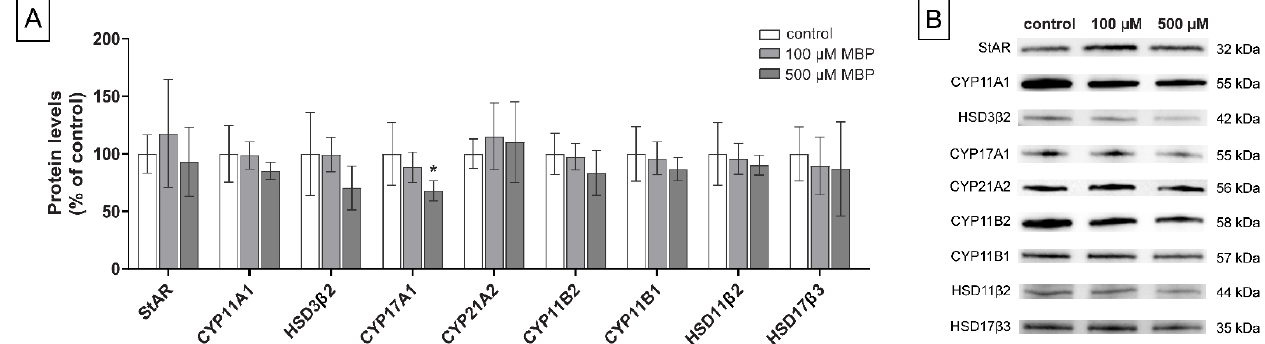
Figure 6. Levels of nine different steroidogenic proteins were measured by western blot ( A ) in H295R cells exposed to 0 (0.1% DMSO, solvent control), 100, or 500 µM MBP for 48 h, with stimulation of the steroidogenesis by 0.1 mM dbcAMP. Values represent mean ± S.D. from six replicates per treatment. Representative blots for each protein are shown ( B ). Total protein stain was used as a loading control. The statistically significant differences from control are indicated as follows: * p < 0.05 (One-way ANOVA followed by Dunnet’s test).